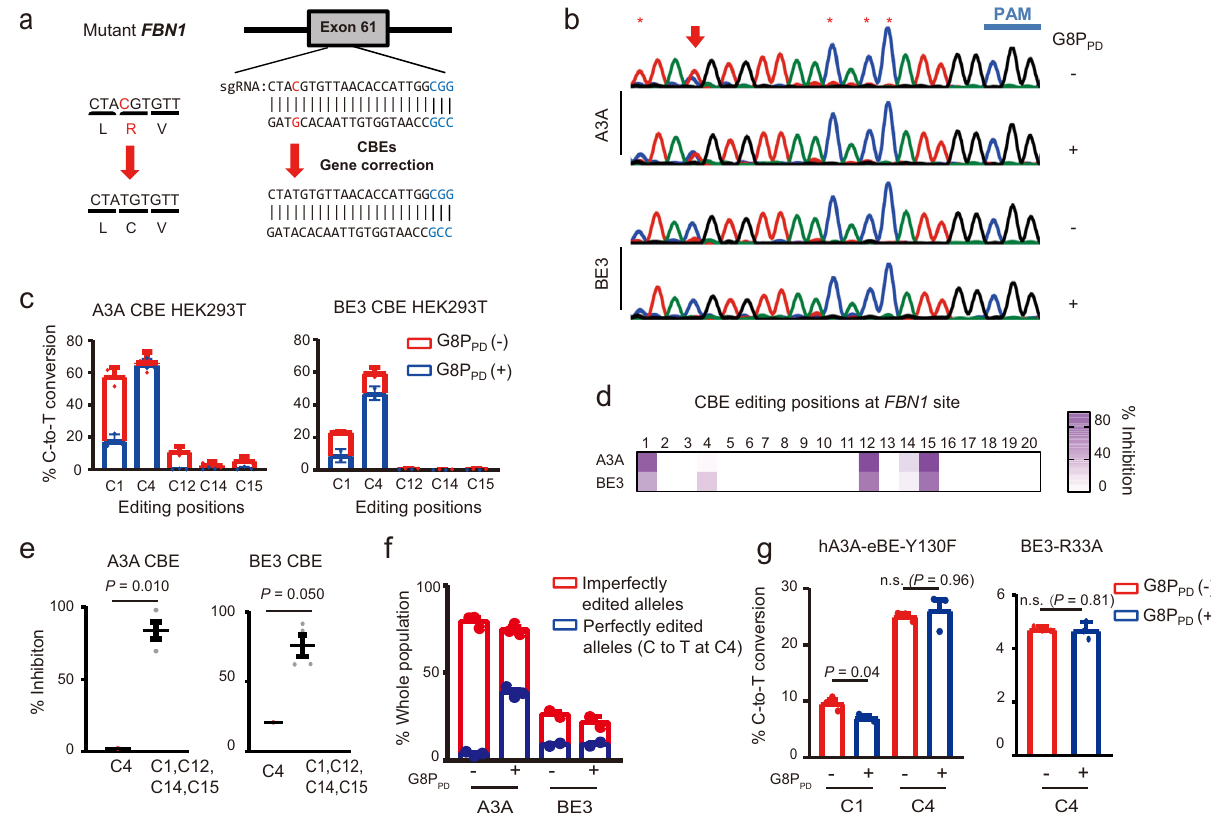
Fig. 4 G8PPD improves the targeting window of CBEs for correction of FBN1T7498C mutation. a Schematic illustration of sgRNA design and the strategy for CBE-based gene correction. b Sanger sequencing of the positive strand of FBN1 illustrating CBE-induced C-to-T mutations. Arrows and asterisks denote on-target and out-of-window cytidine positions for base editing. c Frequency of A3A and BE3 CBE-mediated C-to-T conversion in the absence and presence of f1 G8P PD . The data are shown as mean ± SEM. The A3A and BE3 groups contain 2 and 3 biologically independent replicates respectively. d Heat map showing the position-dependent inhibition of A3A and BE3 CBEs by G8P PD . e Comparison of the inhibition rates of G8P PD at the on-target and out-of-window editing positions of A3A and BE3 CBEs at FBN1 site. Signi fi cant difference is determined using Student ’ s t test. f Analyses of perfectly edited FBN1 alleles in the absence and presence of G8P PD . For e – f , the data are shown as mean ± SEM and the A3A and BE3 groups contain 2 and 3 biologically independent replicates respectively. g The effects of f1 G8P PD on hA3A-eBE-Y130F and BE3-R33A CBEs for correction of FBN1 T7498C mutation. The data are shown as mean ± SEM ( n = 3 biologically independent replicates). For e and g , signi fi cant difference is determined using